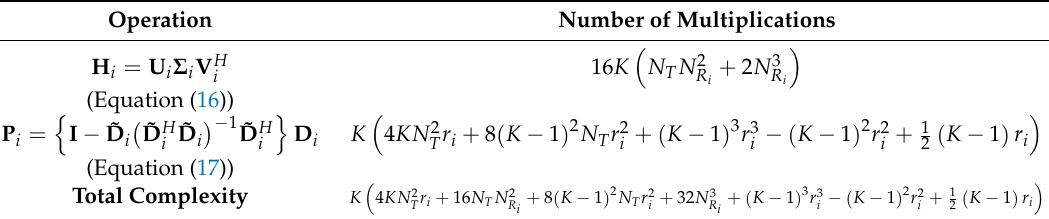
Table 4. Computational complexity for a generalized block diagonalization (GBD) precoder.